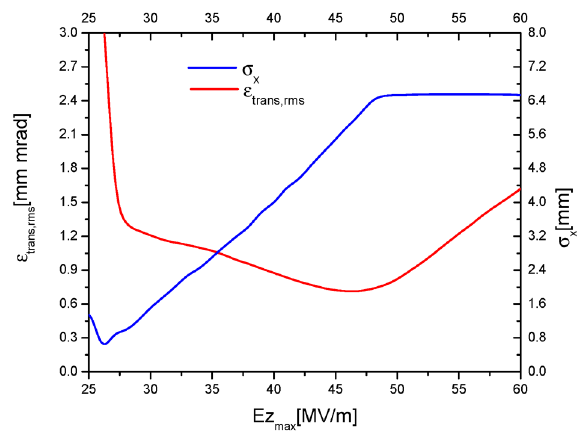
FIG. 5. (Color) Dependence of the transverse emittance on the (cid:1) 50 MV = m . phase of the TE mode. E max z